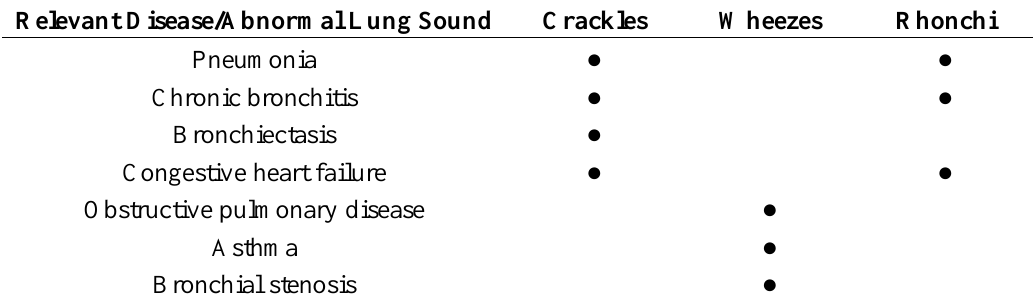
Table 1. Associations between abnormal lung sounds and lung diseases